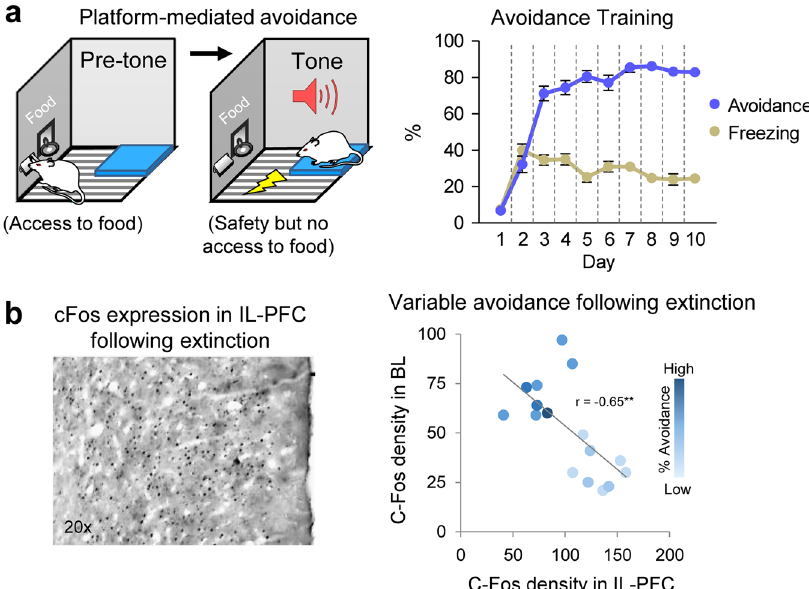
Fig. 4 Platform-mediated avoidance task. a Food-deprived rats pressing a bar for food are exposed to a tone paired with a footshock. Over several days of training, rats learn to avoid the shock by stepping onto a platform on the opposite side of the chamber far from the food bar (con fl ict). As avoidance is acquired, freezing to the tone (fear) is reduced. Source : Ref. 72. b Following 2 days of extinction training (tones without shocks), most rats cease avoiding and remain at the food bar when the tone is presented. However, some rats continue to avoid. The immediate early gene cFos, an activity marker, reveals that rats continuing to avoid have elevated activity in BL and reduced activity in IL-PFC. Similar to the Robogator task above, BL activity is associated with lack of movement toward food, perhaps due to a failure of inhibition by inputs from IL. Source : Ref.